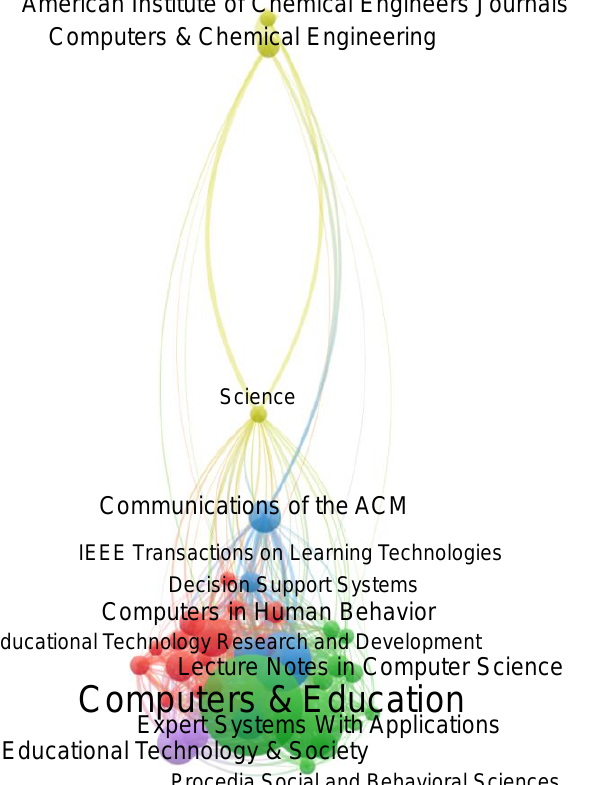
Figure 4 Most Cited Journals (Co-Citation